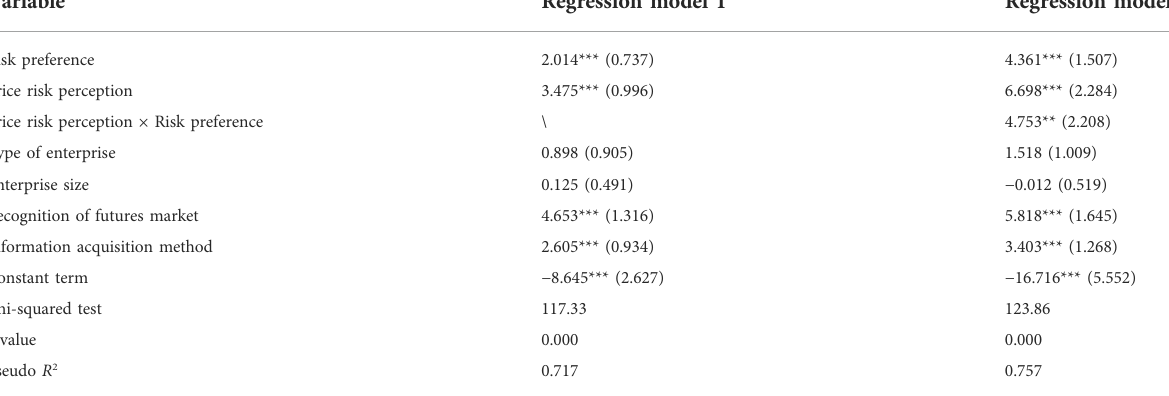
TABLE 3 In fl uencing factors of enterprise willingness to participate in